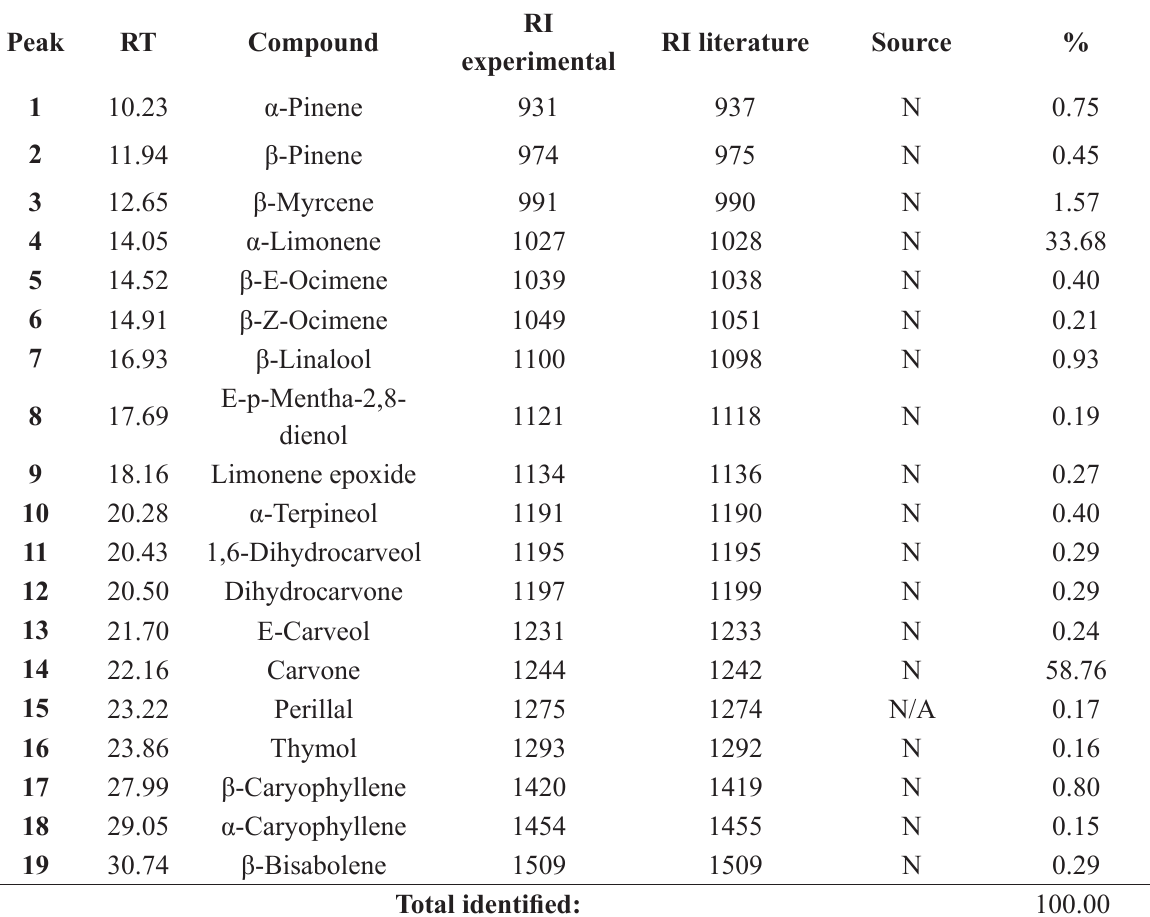
Chemical composition of the essential oil from dried leaves of Aloysia